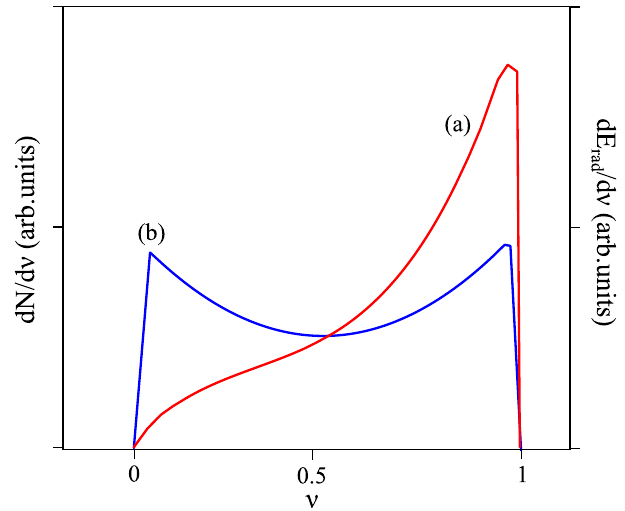
FIG. 2. Distributions of photon energy E (a) (right axis) and rad photon number N (left axis) (b) in linear scale, arbitary units, as rad function of the normalized photon frequency ν ¼ ν p = ð 4 ν 0 γ 2 Þ